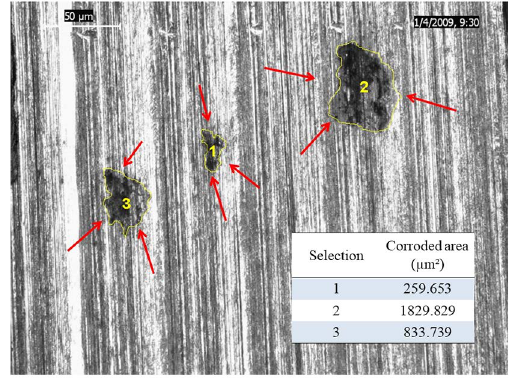
Figure 5. Optical image of corroded regions in AA7075-T73 alloy during simulated machining process and the respective